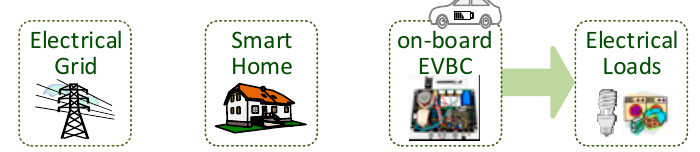
Figure 9. On-board EVBC: Vehicle-to-load (V2L) operation mode (as a voltage source).